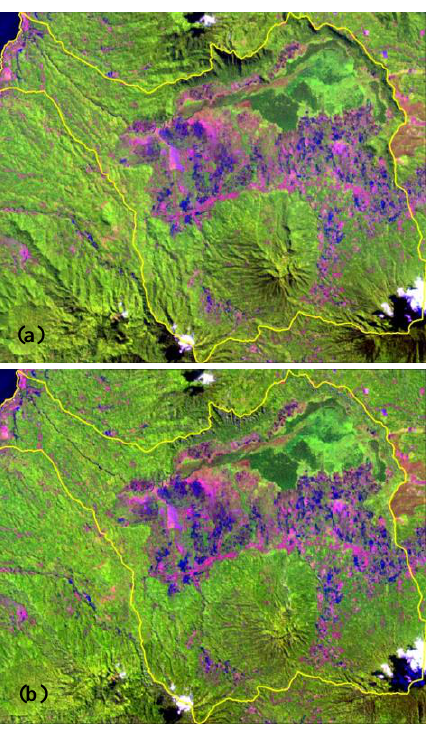
Figure 3. Landsat 8 OLI image comparison (a) before and (b) after topographic correction